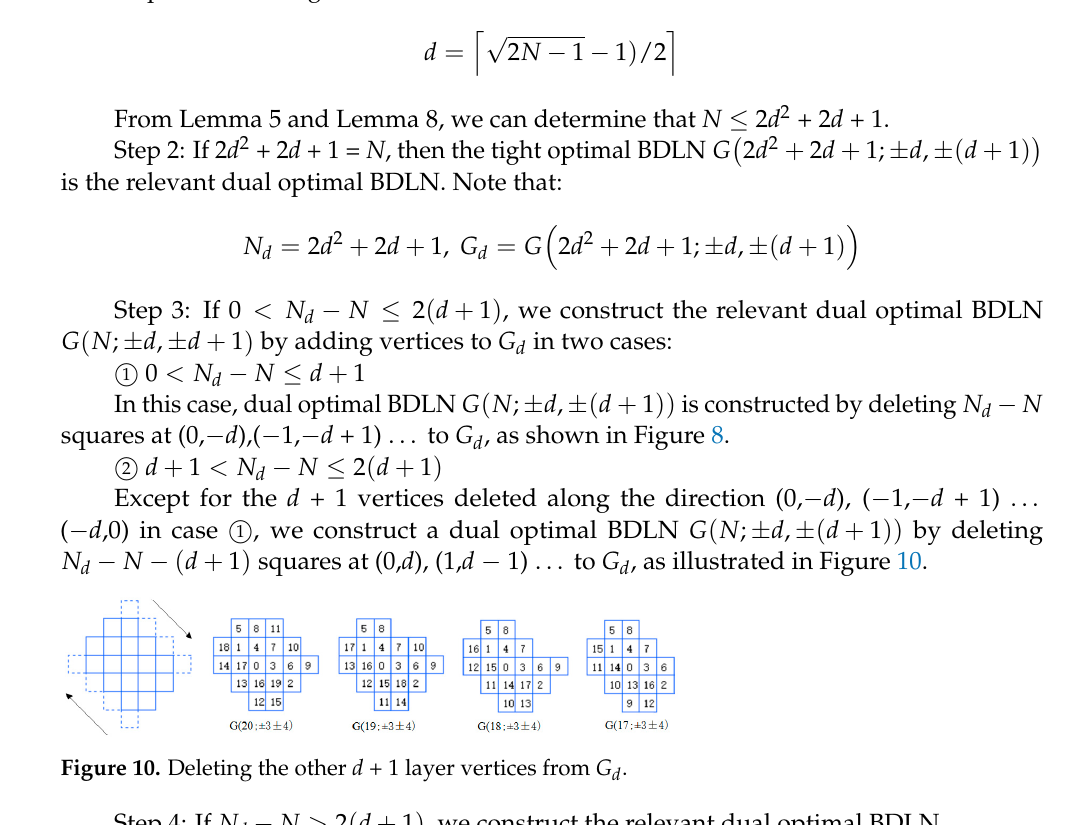
Figure 9. Algorithm for constructing a dual optimal BDLN.